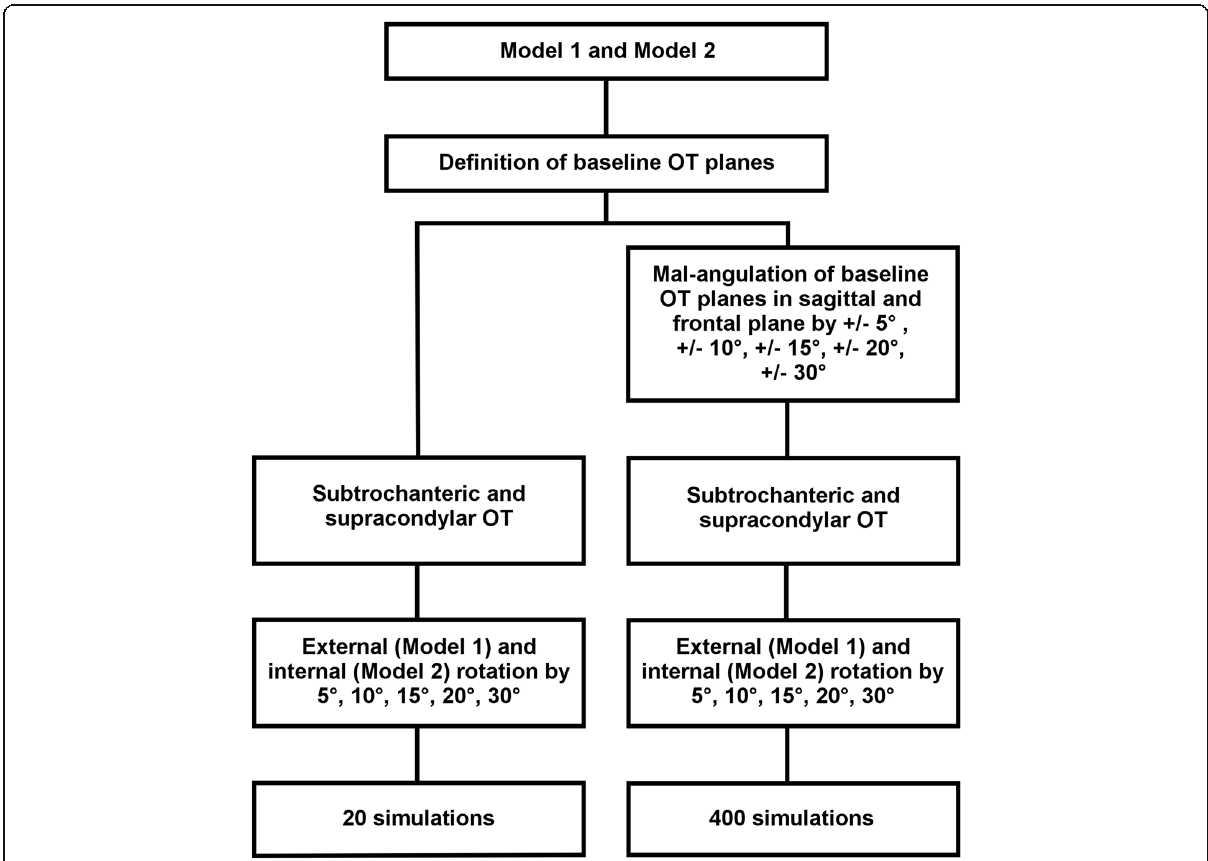
Fig. 5 Flowchart of the performed simulations. OT: Osteotomy